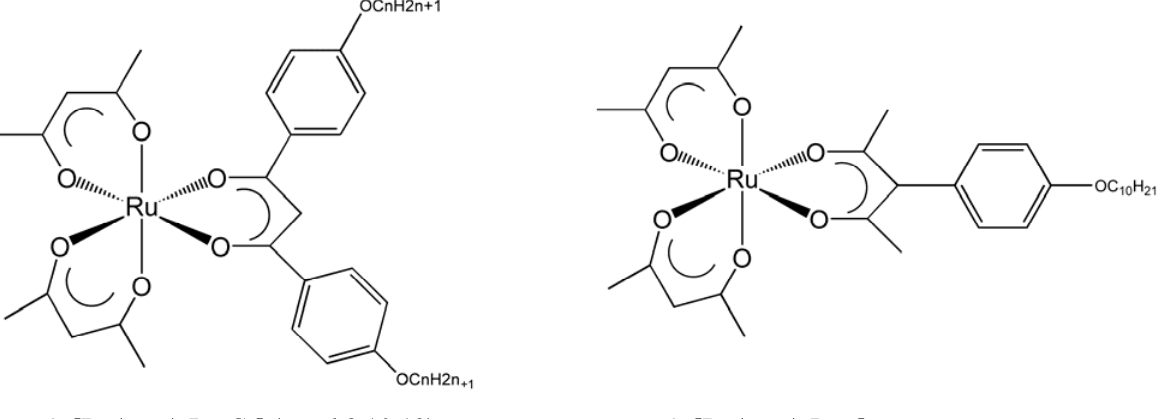
L C ] (right) 2 per 6